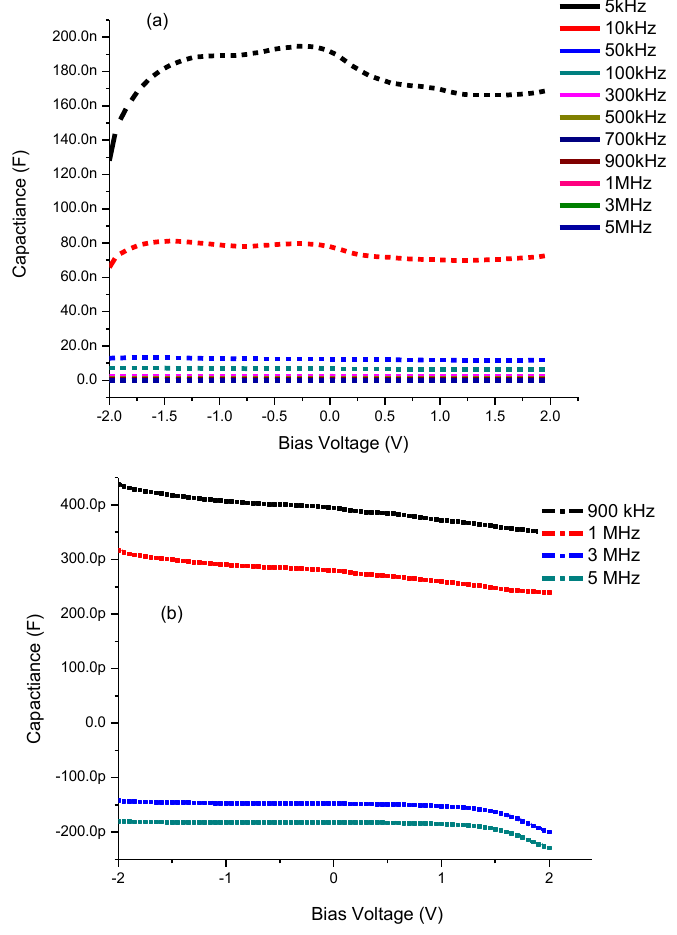
Figure 7. Capacitance-Voltage characteristics of CdS QD based on screen-printed TiO 2 ( a ) at all frequencies and ( b ) negative capacitance after 1 MHz